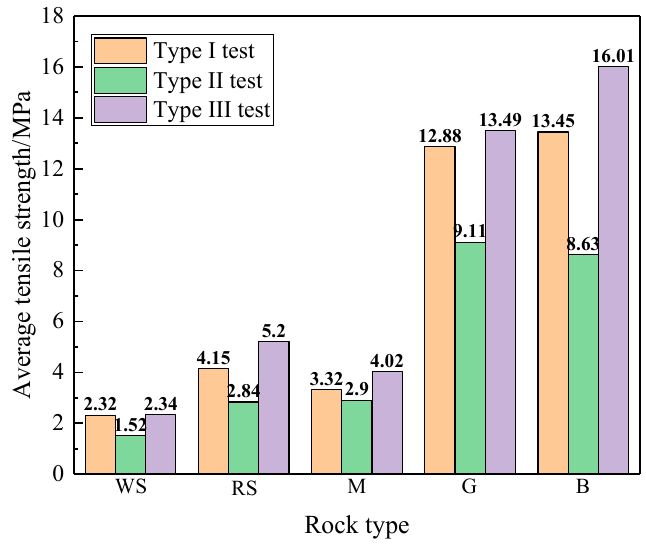
Figure 3. Average tensile strength of different rock types under three typical loading configurations.